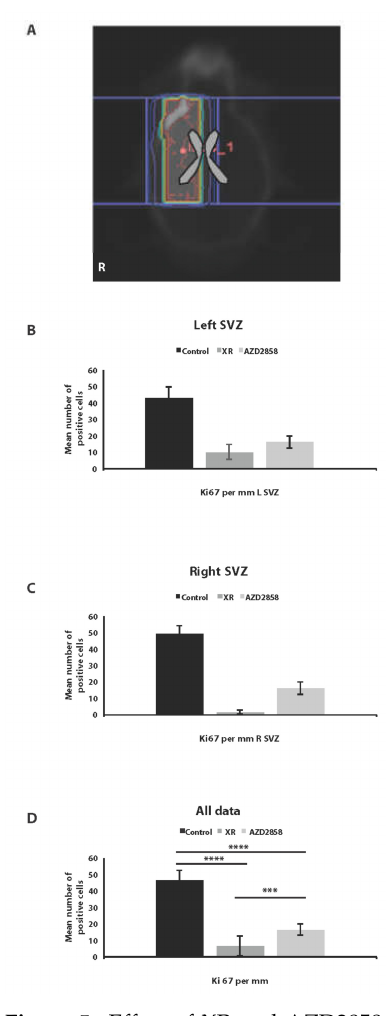
Figure 5. Effect of XR and AZD2858 on cell division. Ki67 staining in fixed normal brain from the U87 orthotopic intracranial BALB/c Nude mice model showing the effect of XR and AZD2858, respectively, on cell division in SVZ. Right SVZ was in the high dose RT field, left SVZ in low dose region in each case. ( A ) Representative dose contour map showing XR dose distribution in a treated animal. High dose volume is defined by yellow contour, low doses in purple. The ventricular system is outlined in grey. ( B ) Graph illustrating the result for the left SVZ, ( C ) for the right SVZ in irradiated, control, and drug-treated animals, and ( D ) all data combined (control vs. XR, p = 1.5 × 10 − 12 ; control vs. drug; p = 9.4 × 10 − 13 ; XR vs. drug, p = 8.2 × 10 − 5 ). *** denotes p ≤ 0.001 and **** denotes p ≤